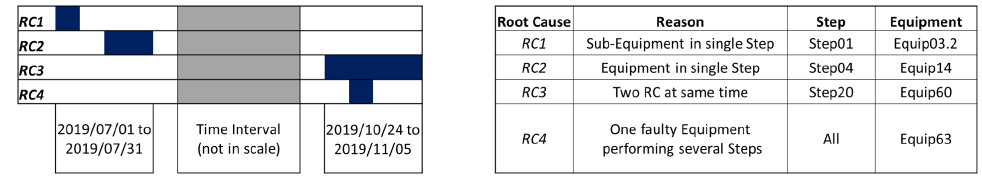
Figure 6. Root causes defined in the simulated datasets [32].